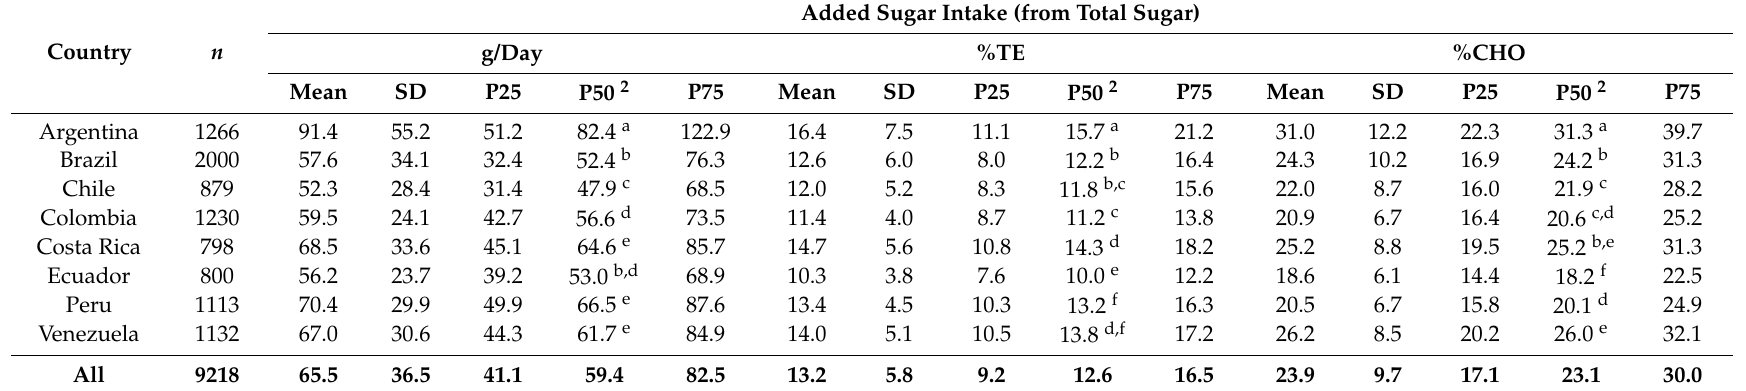
Table 2. Added sugar intakes 1 in individuals residing in urban areas of Latin American countries; Latin American Health and Nutrition Study (ELANS), 2015.